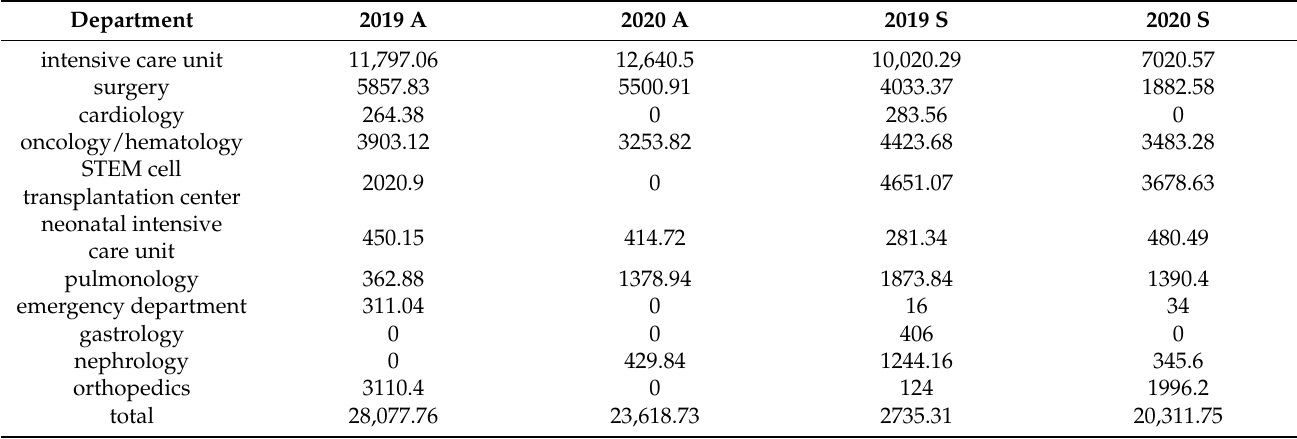
Table 10. Costs of antibiotics by category (PLN) (average exchange rate in 2020: 1 USD = 3.8972 Table 11. Costs of class 3 antibiotics by hospital department (PLN) (average exchange rate in 2020: 1 USD = 3.8972 PLN).